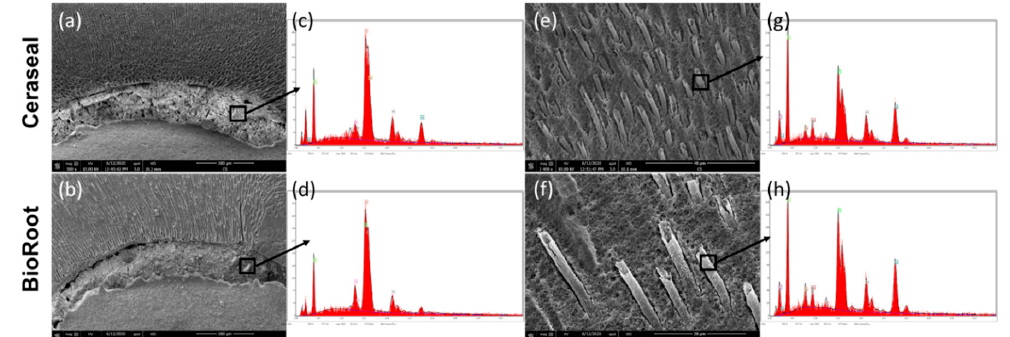
Figure 3. Representative photos of scanning electron microscopy of sectioned root surfaces filled with